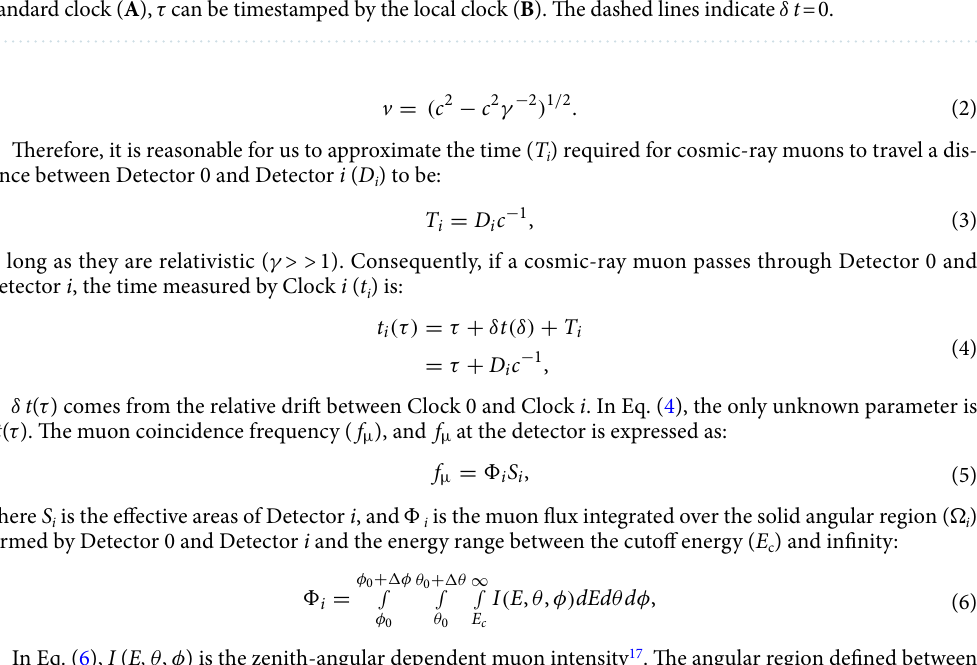
Figure 1. Relationship between local time ( t ) and standard time ( τ ). While t can be timestamped by the standard clock ( A ), τ can be timestamped by the local clock ( B ). The dashed lines indicate δ t =